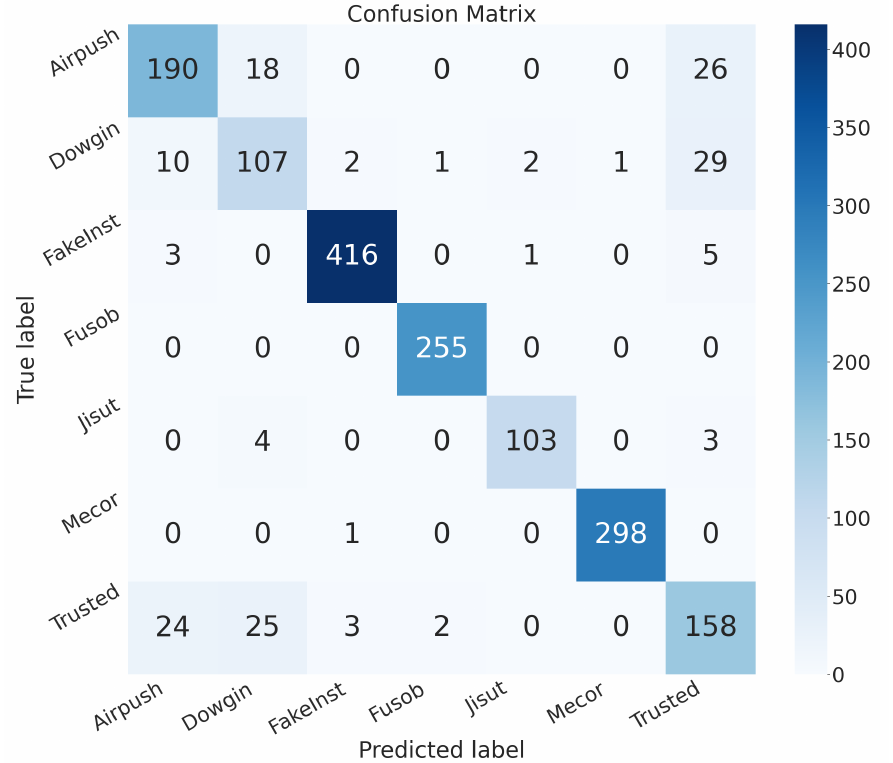
Figure 7. Confusion matrix obtained with the Hybrid-QCNN model for the family classifi- cation